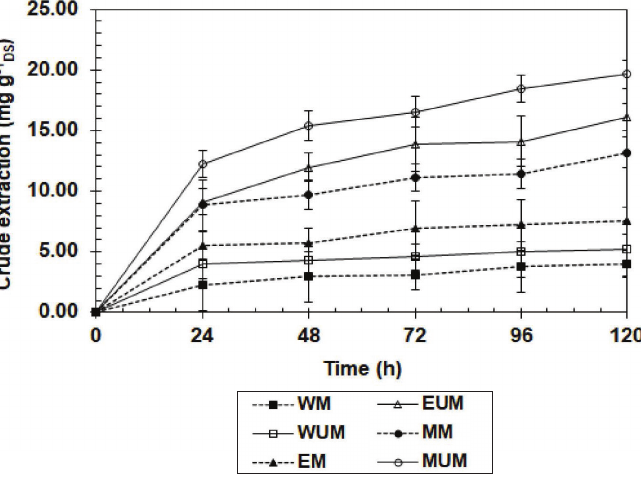
Fig. 3 – Extraction yield of BTP in water, ethanol, and meth- anol by maceration (WM, EM, MM) and ultra- sound-maceration method (WUM, EUM,